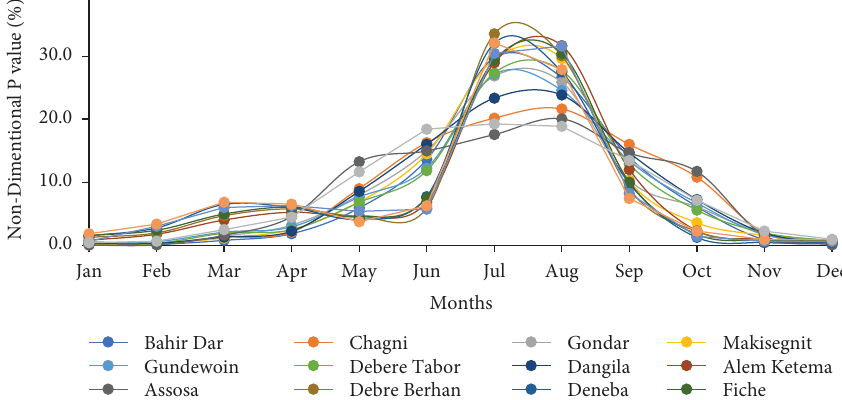
Figure 3: Rainfall data homogeneity test in the Abbay river